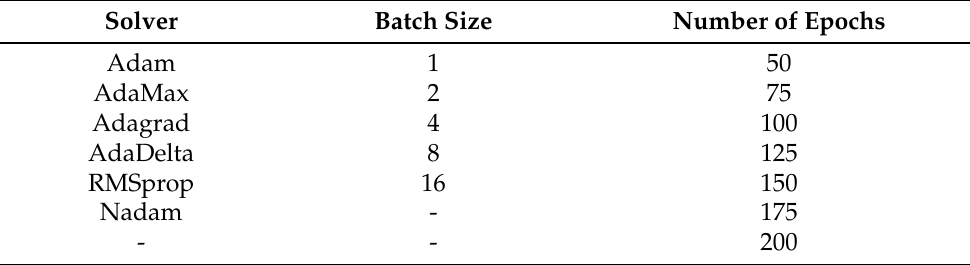
Table 5. Overview of U-net hyperparameters used during grid-search